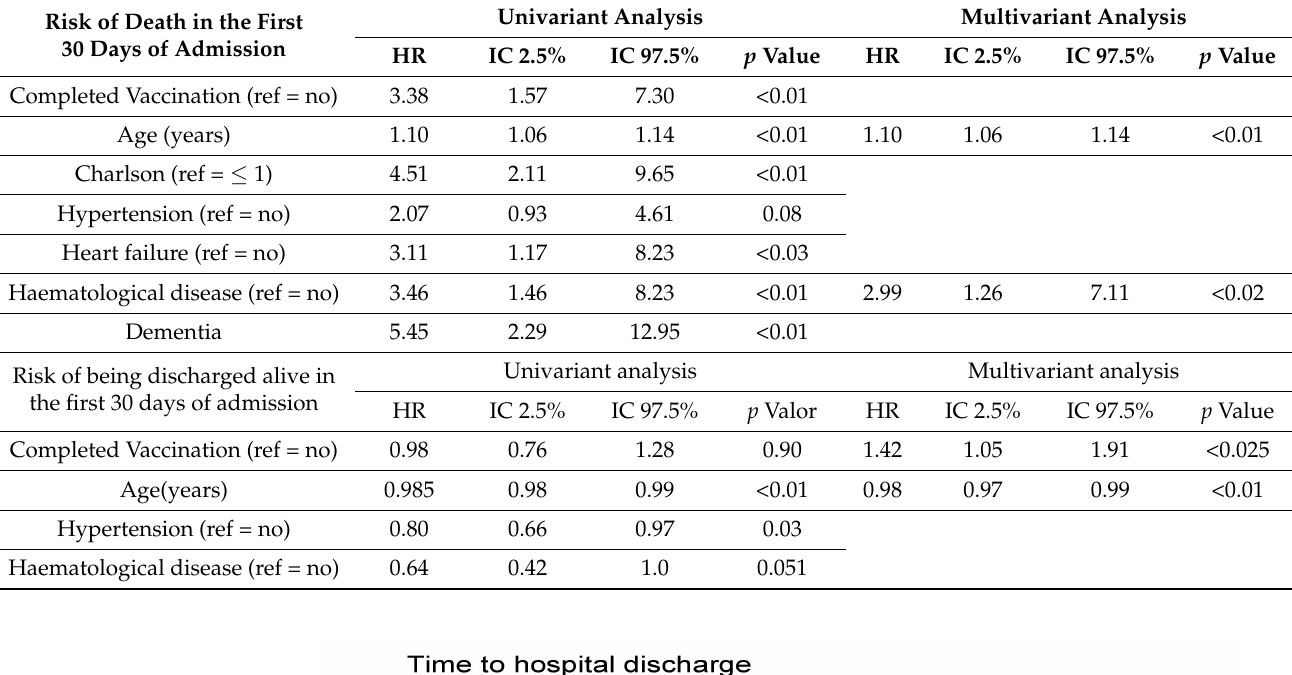
Table 6. Cox analysis: risk of death in the first 30 days of admission and risk of being discharged alive in the first 30 days of admission.